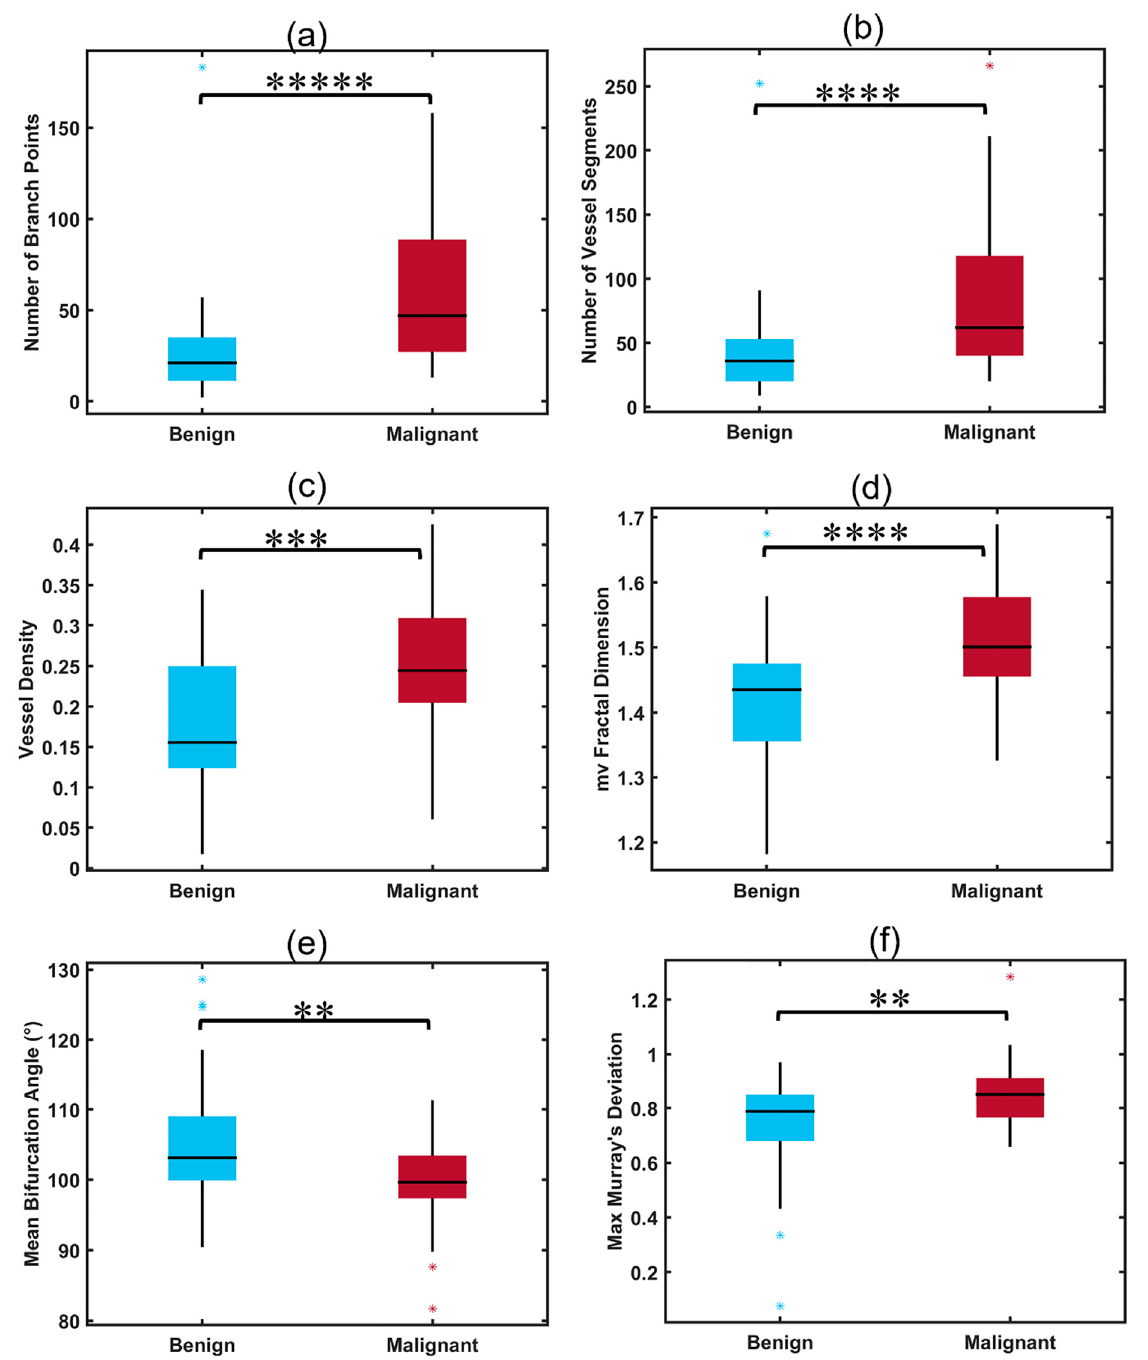
Figure 3. Box plots illustrating distributions of significant HDMI parameters for benign and malignant thyroid nodules. ( a ) Number of branch points (NB), ( b ) number of vessel segments (NV), ( c ) vessel density (VD), ( d ) microvessel fractal dimension (mvFD), ( e ) mean bifurcation angle (BA mean ), ( f ) maximum Murray’s deviation (MD max ), ** p < 0.01, *** p < 0.001, **** p < 0.0001, ***** p < 0.00001. Benign ( n = 57), malignant ( n = 35).